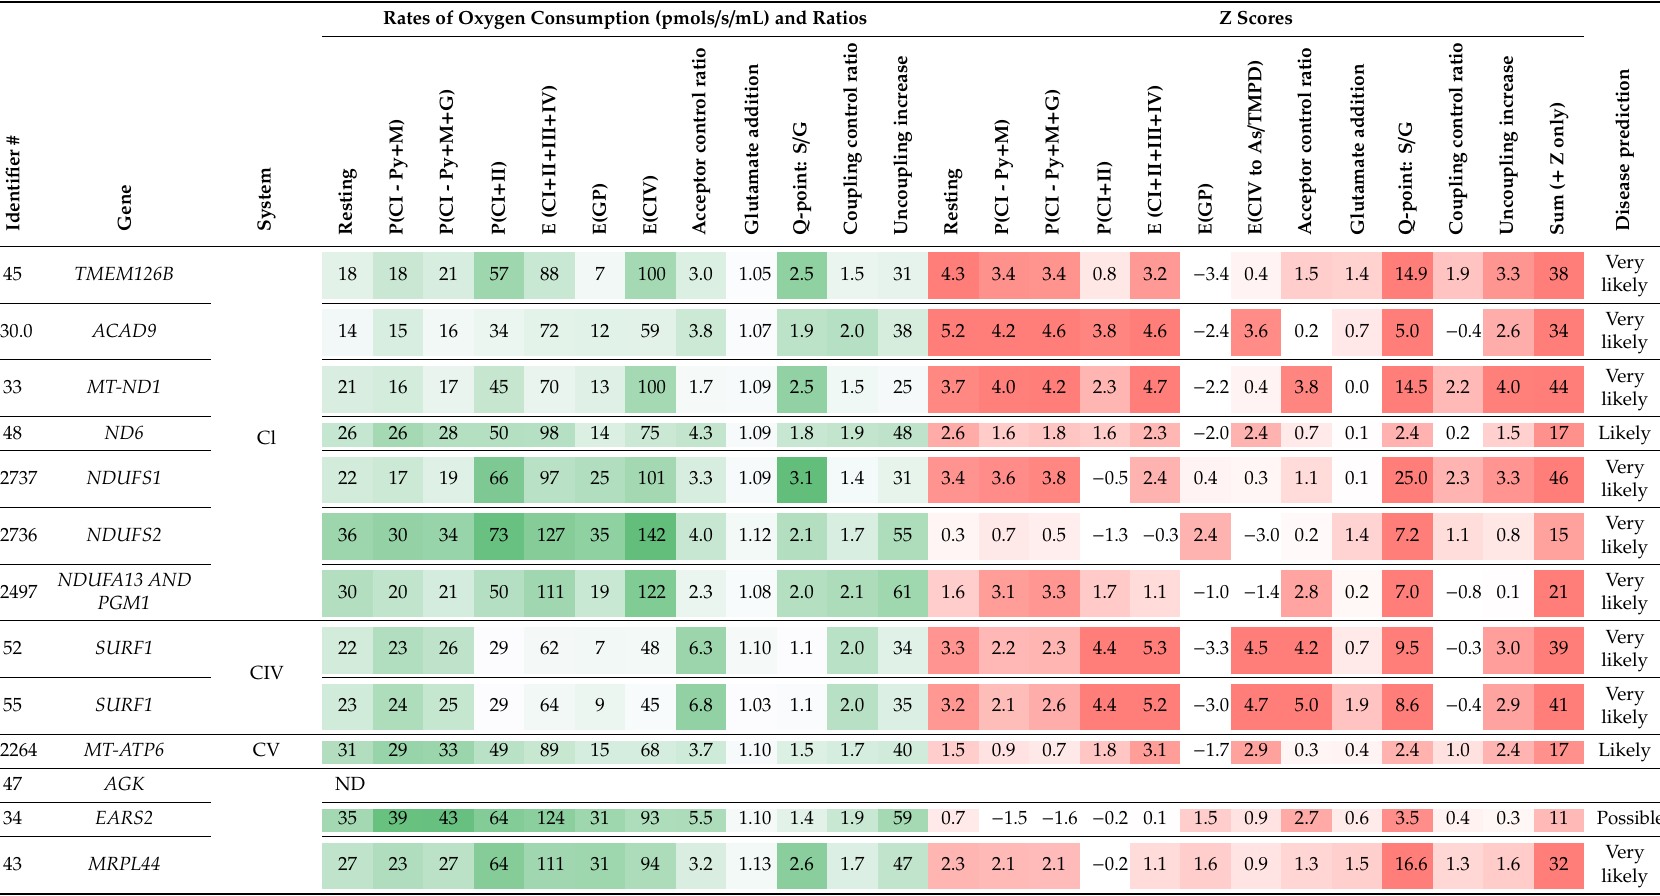
Table 3. Oxygraphy testing results and disease predictions. Oxygraphy values for individual cell lines as grouped based on the system a ff ected. Disease prediction was assigned using Z scores as described in the Materials and Methods. Abbreviations: As, ascorbate; CI–IV, OXPHOS complexes I–V; CS, citrate synthase; E, electron transfer state; Gp, glycerophosphate; G, glutamate; M, malate; P, phosphorylating state; Py, pyruvate; S, succinate; Str, structural.